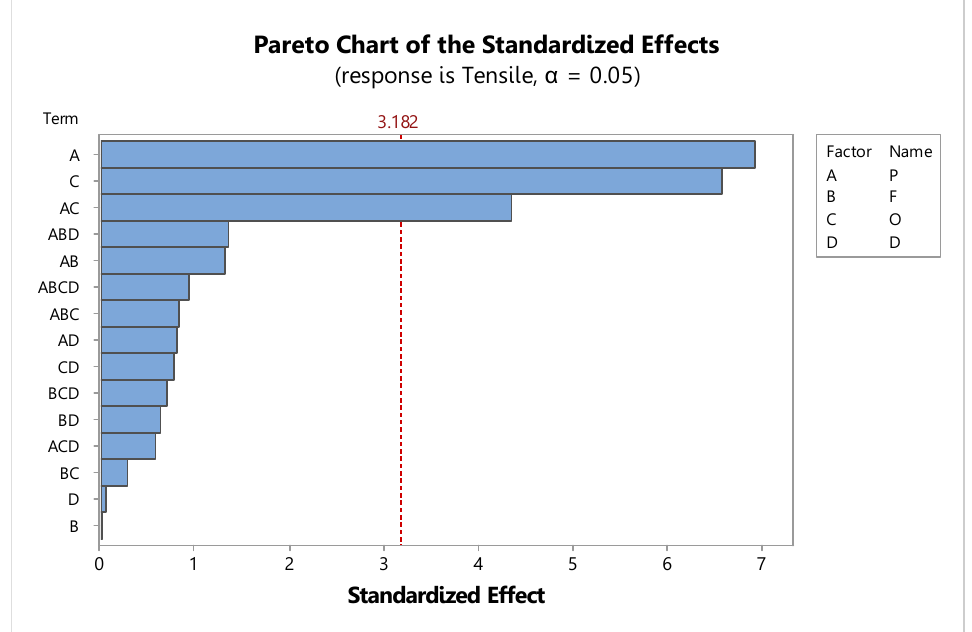
Figure 11. Pareto chart of the standardized effects for deep rolling. Table 8. Analysis of variance for deep rolling.